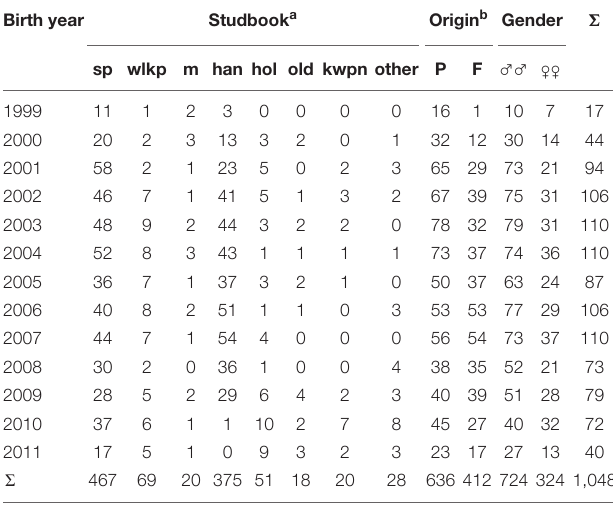
TABLE 1 | Reference population size with the birth year, studbook record, origin, and sex. Birth year Studbook